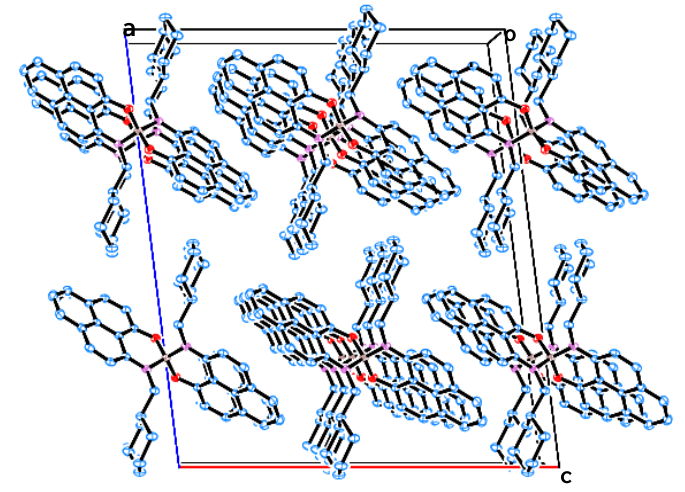
Figure 3. Packing of the molecules viewed along b -axis.